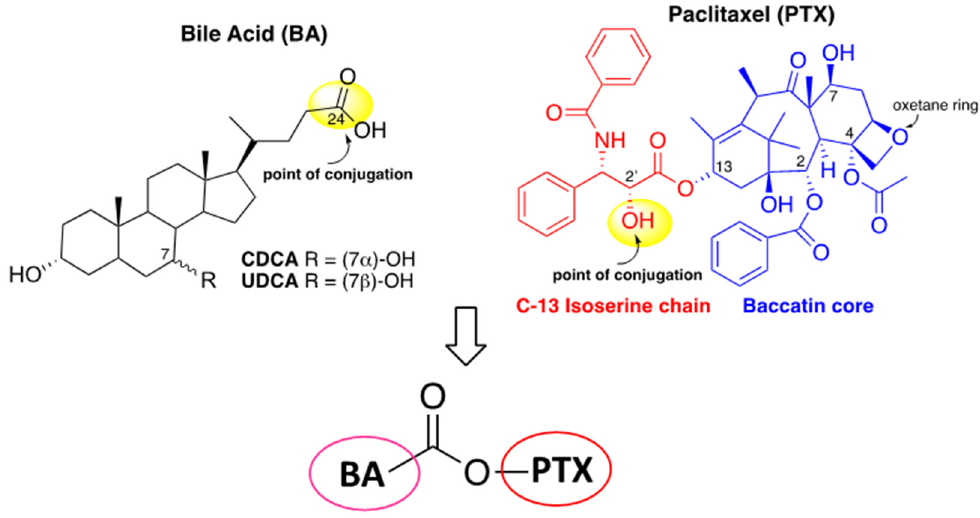
Figure 1. CDCA, UDCA, PTX structures and BA-PTX hybrids sketch.